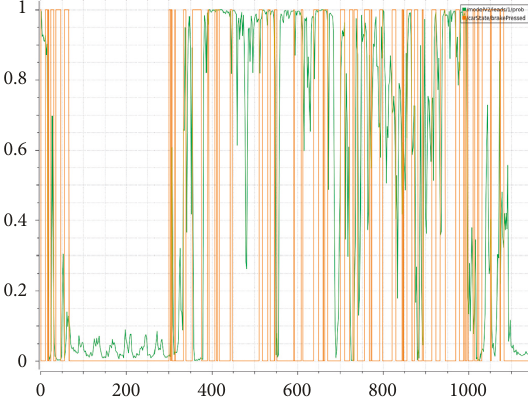
Figure 36: T1N2 lead car detection and